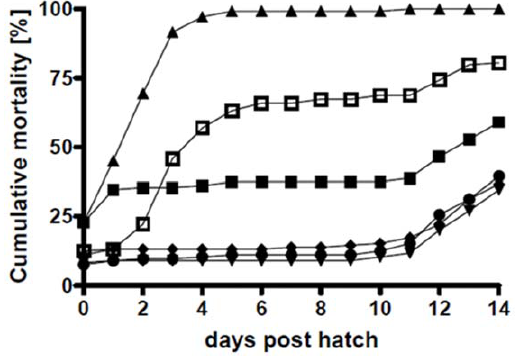
Figure 7. Mortality of cod larvae during the challenge trials. Mean values of two independent triplicate experiments. The single- N larvae cultures were simultaneously inoculated with P. gallaeciensis wild ), or with the TDA-negative mutant of P. type and V. anguillarum (T5, gallaeciensis and V. anguillarum (T6, % ). Unexposed larvae and larvae exposed to single bacterial strains acted as controls: Negative Control (T1, & ), only V. anguillarum (T2, m ), only P. gallaeciensis wild type (T3, . ), and only P. gallaeciensis TDA-negative mutant (T4, ¤